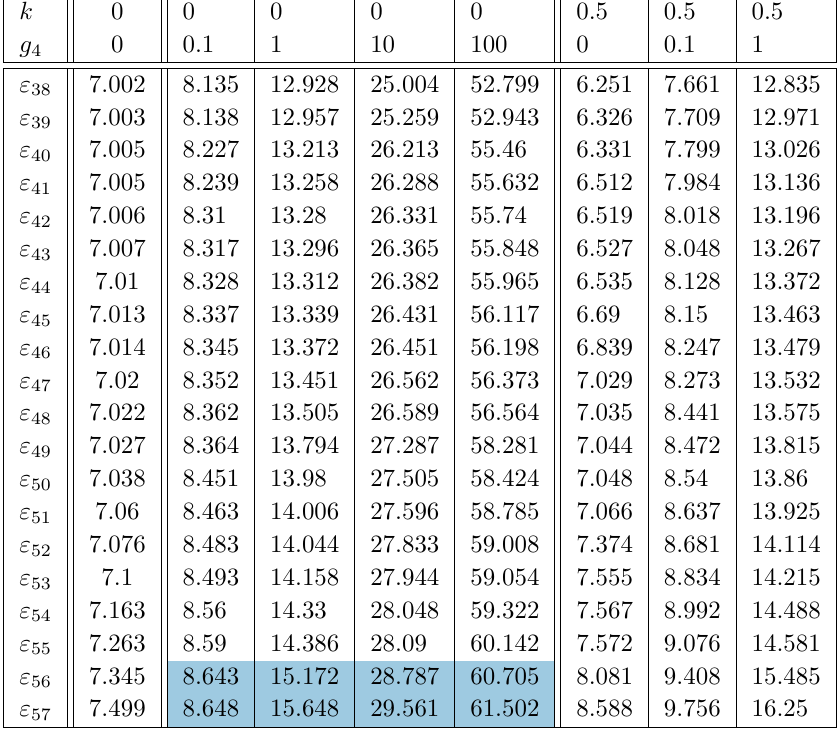
Table 17. Two-matrix spectrum with loop length truncation l = 7